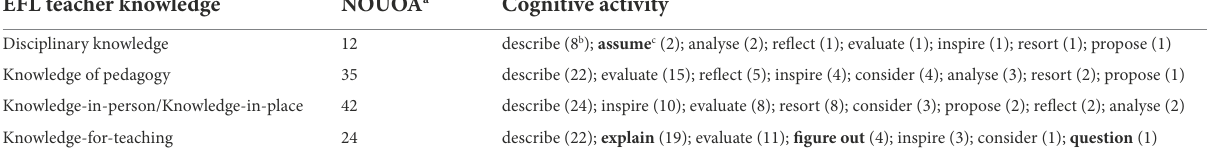
TABLE 5 Cognitive activities for different types of EFL teacher